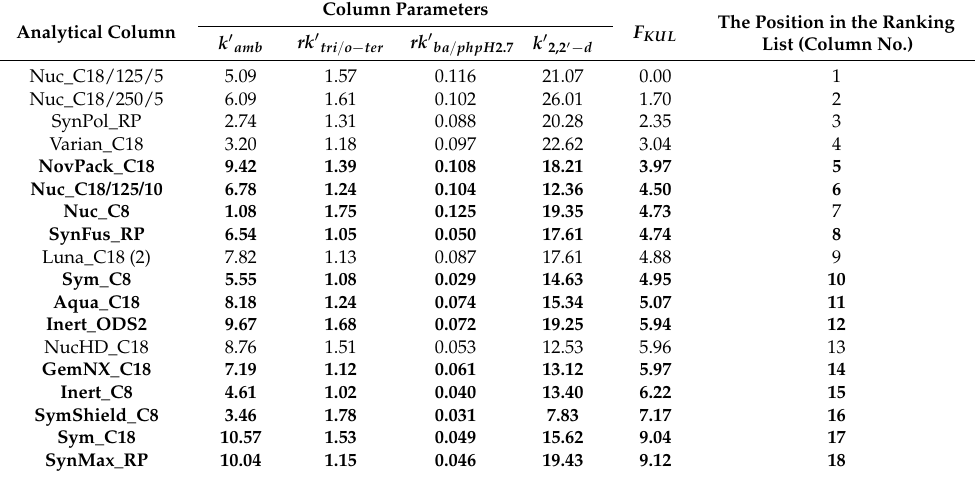
Meaning of symbols is explained in the text. The columns non-suitable for the separation of the analytes are indicated in